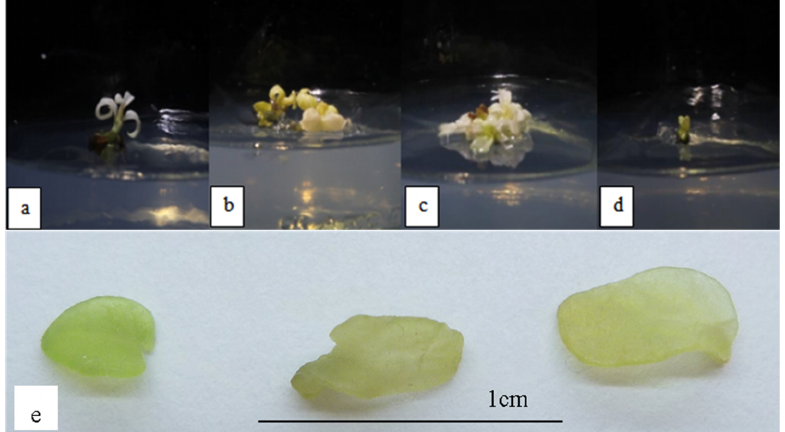
Figure 1. O. stamineus subjected to NaCl stress harvested after the third subcultures: ( a ) 0.001 mg/L NaCl; ( b ) 0.002 mg/L NaCl; ( c ) 0.003 mg/L NaCl; ( d ) 0.004 mg/L NaCl; ( e ) hyperhydricity observed in leaves subjected to NaCl stress.